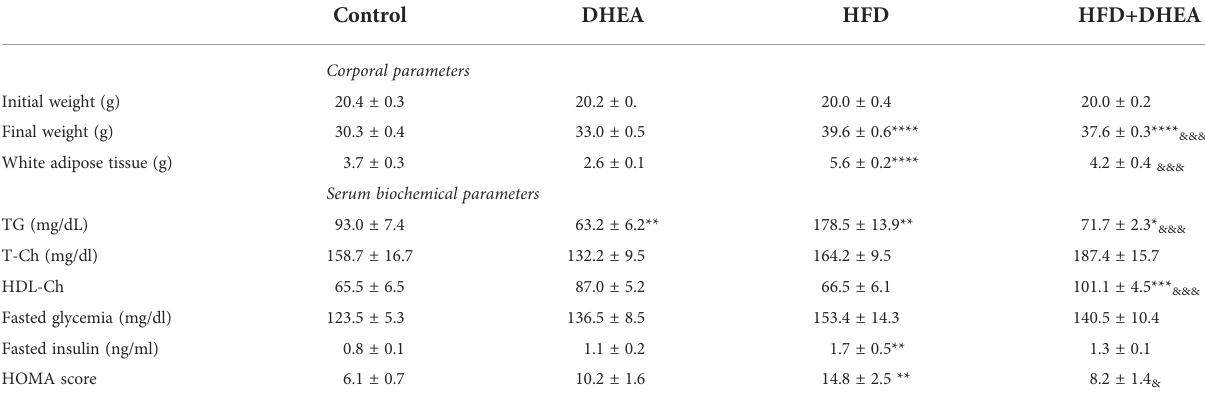
Body weight was measured along the experiment and statistically analyzed at the fi nal point; the adiposity index is the sum of the total white adipose tissue relative to body weight; biochemicalparametersweremeasuredattheendofthetreatment.Dataaremeans±SEM(n=9).*P<0.05,**P<0.01,***P<0.001****P<0.0001versusC; & P<0.05, &&& P<0.001versus HFD according to one-way ANOVA analysis with multiple